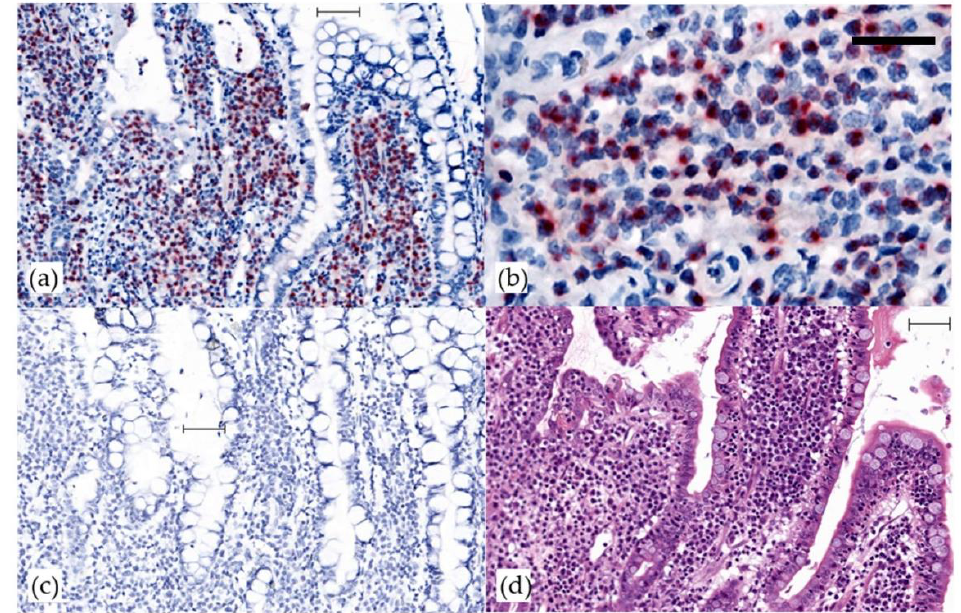
Figure 1. Detection of FcaGHV1 by in situ hybridization in an intestinal, large, granular lymphocyte lymphoma. In situ hybridization for FcaGHV1 ORF 50. Bars 50 micrometers. ( a ) A strong intranuclear signal (red) labels >90% of infiltrating neoplastic lymphocytes that are densely packed within intestinal villi. Counterstain, hematoxylin; ( b ) high power image to show nuclear staining of neoplastic lymphocytes; ( c ) no staining with negative control probe DapB ( d ) hematoxylin and eosin